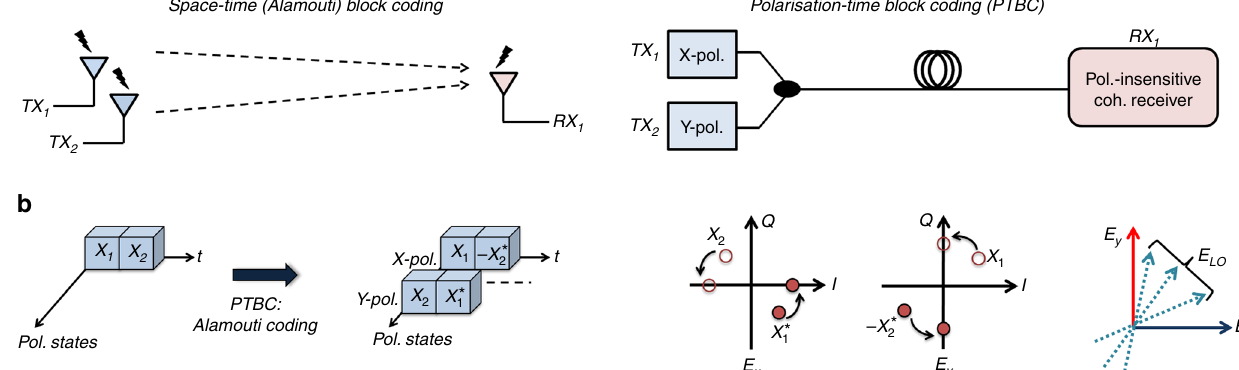
Fig. 2 Realisation of Alamouti coding. a The analogy between wireless (two transmit antennae) and optical fi bre communication (dual-polarisation transmitter), corresponding to a multiple-input-single-output system. b Alamouti polarisation-time block coding (PTBC) scheme and the illustration of polarisation rotation. E X and E Y correspond to the optical fi elds carrying the information and coded symbols ( X 1 X 2 ½ (cid:2) and (cid:3) X (cid:4) Y-polarisation modes, generated using transmitter 1 and 2 ( TX 1,2 ). Subsequently, the transmitted signal beats with the local oscillator E LO in the receiver ( RX 1 ). I in-phase,